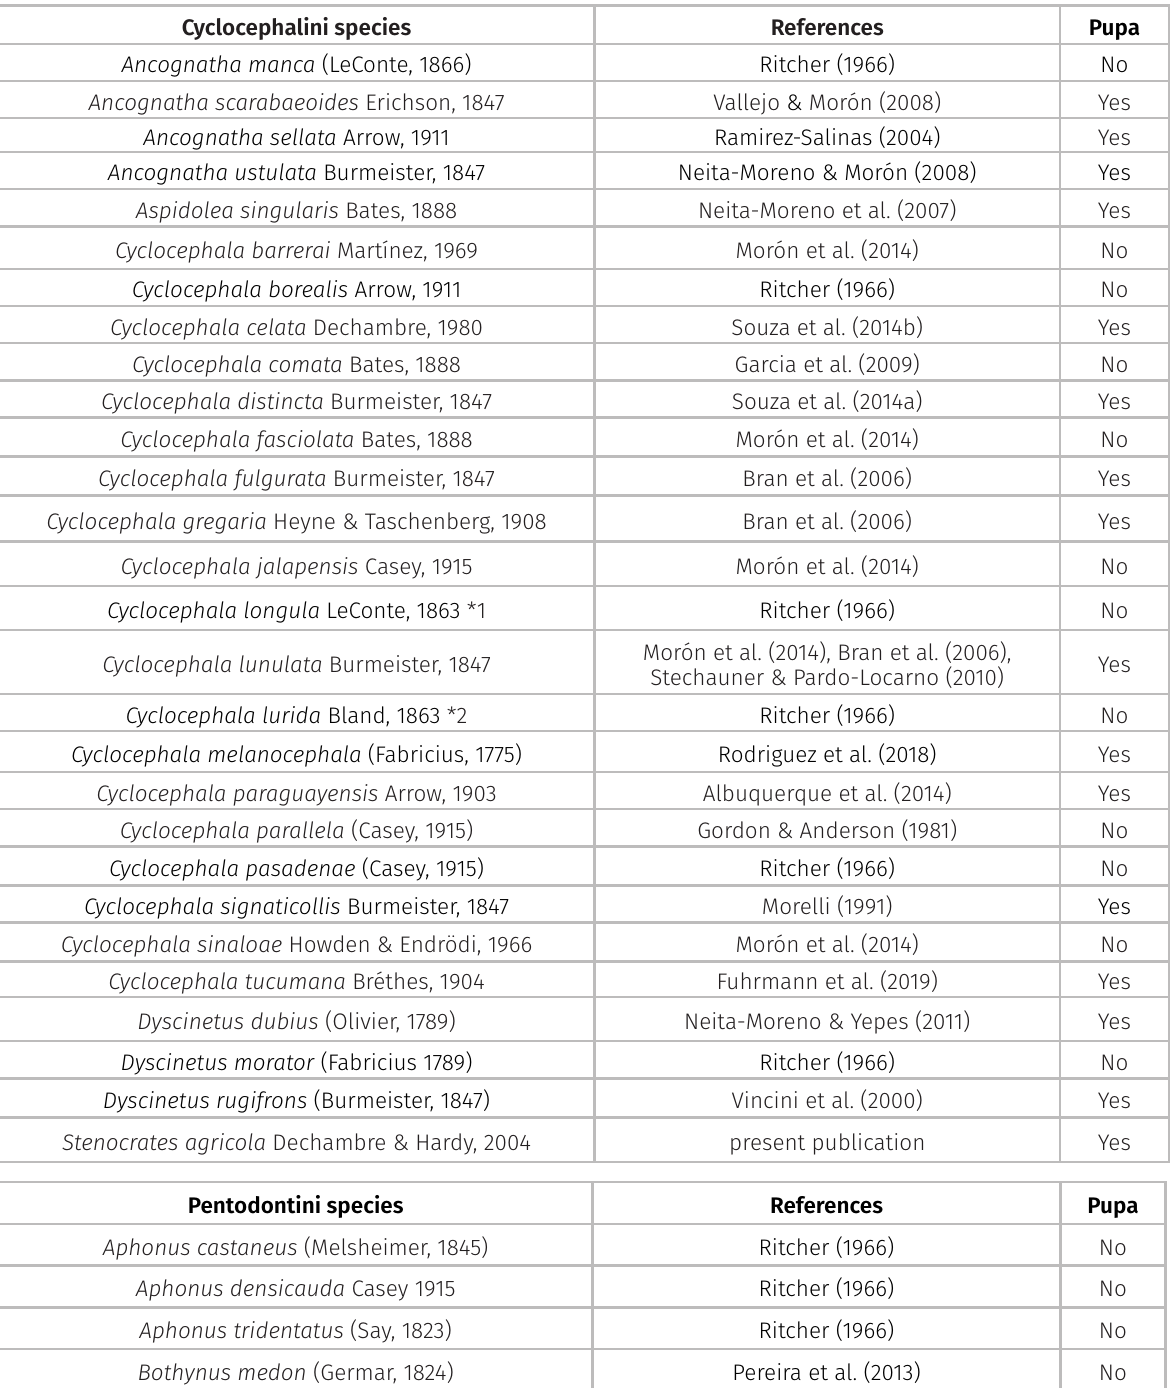
Table I. Described third instars of Cyclocephalini and Pentodontini species. *1 - cited as Cyclocephala abrupta Casey, 1863 (junior synonym) by Ritcher (1966); *2 - cited as C. immaculate (Olivier, 1789) (junior synonym) by Ritcher (1966); *3 - cited as Bothynus gibbosus (De Geer, 1774) (new combination) by Ritcher (1966); *4 - cited as Ligyrus gianucai Dechambre & Lumaret (1985) (junior synonym) by Neita & Ratcliffe (2017); *5 - cited as Cheiroplatys pyriformis (LeConte, 1847) (junior synonym) by Ritcher